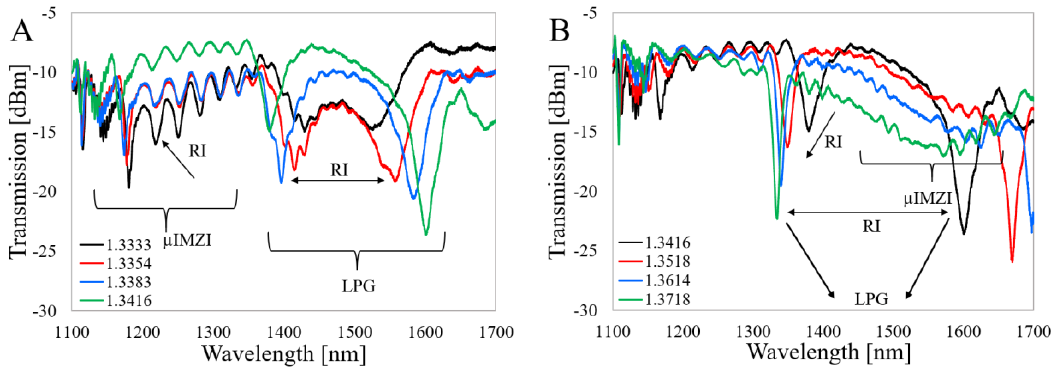
Figure 6. Spectral responses of the Al 2 O 3 -LPG-µIMZI structure to RI in its range ( a ) from 1.3333 to 1.3416 RIU and ( b ) from 1.3416 to 1.3718 RIU. The effects corresponding to the Al 2 O 3 -LPG and µIMZI are marked.